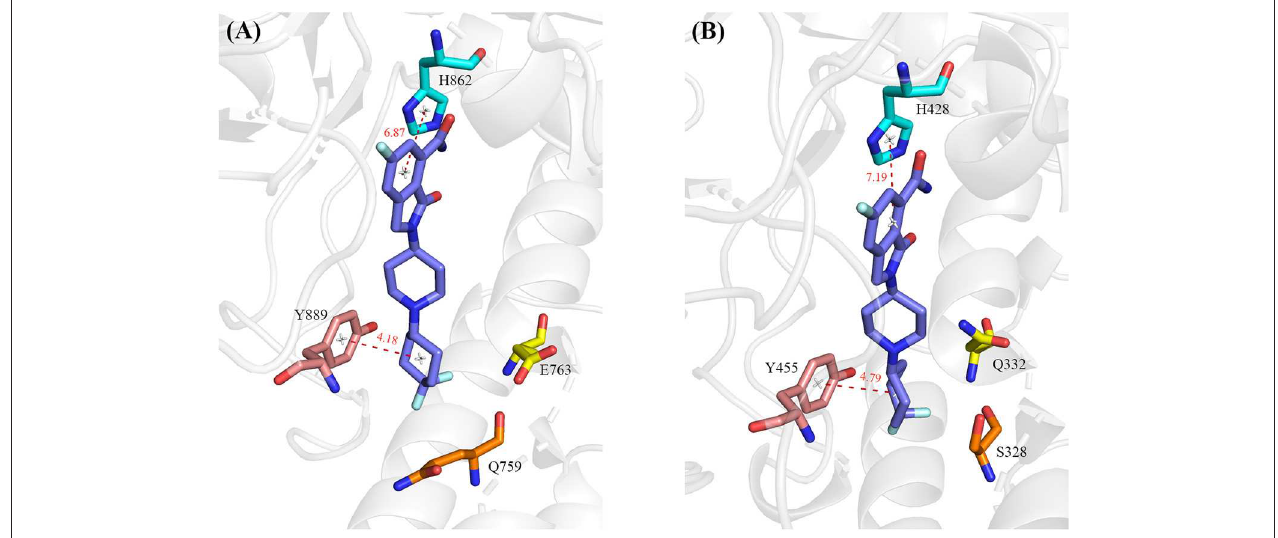
FIGURE 8 | The hot-spot residues that are responsible for the different binding affinity in PARP-1 ( A , PDB ID: 5A00) and PARP-2 ( B , PDB ID: 4ZZY). The protein is shown in cartoon, and the residues and ligand are shown in sticks. The red dashed lines indicate distance between PARP1/2 residues and the ligand.